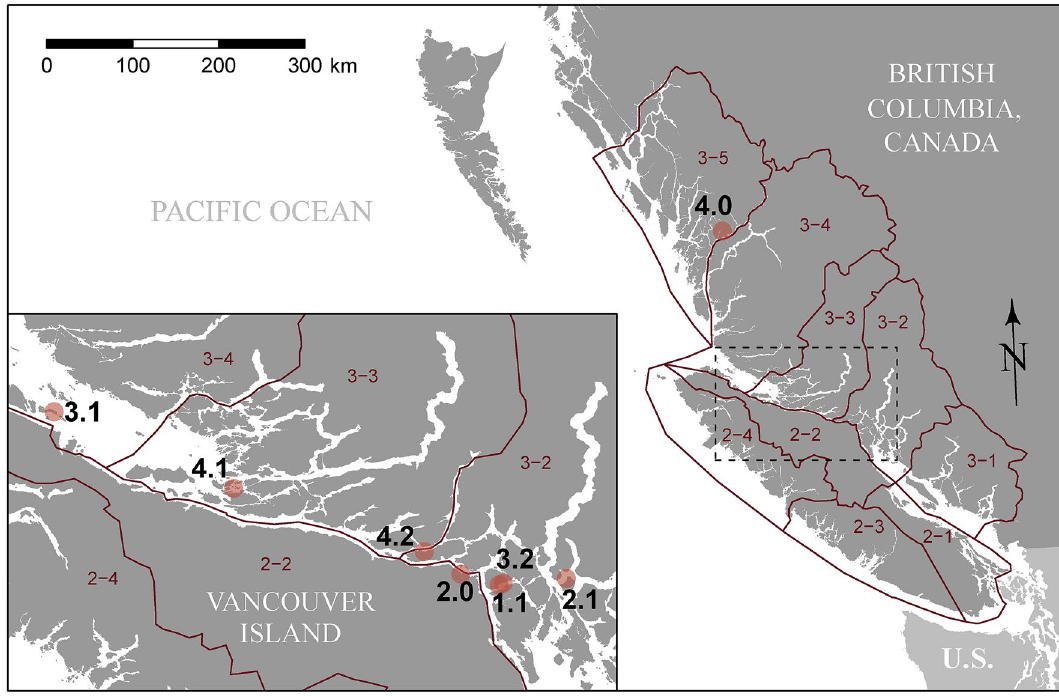
Figure 1. Atlantic salmon-farm locations (points) for the four cohorts from which samples were collected for this study, in relation to Fisheries and Oceans Canada’s Aquaculture Management Zones (2–1 through 3–5). For each farm location, labelled x . y , x indicates a cohort of salmon (1 through 4) while y indicates successive locations of that cohort: 0—freshwater hatchery, 1 & 2 (in some cases)—sequential saltwater net-pen locations.